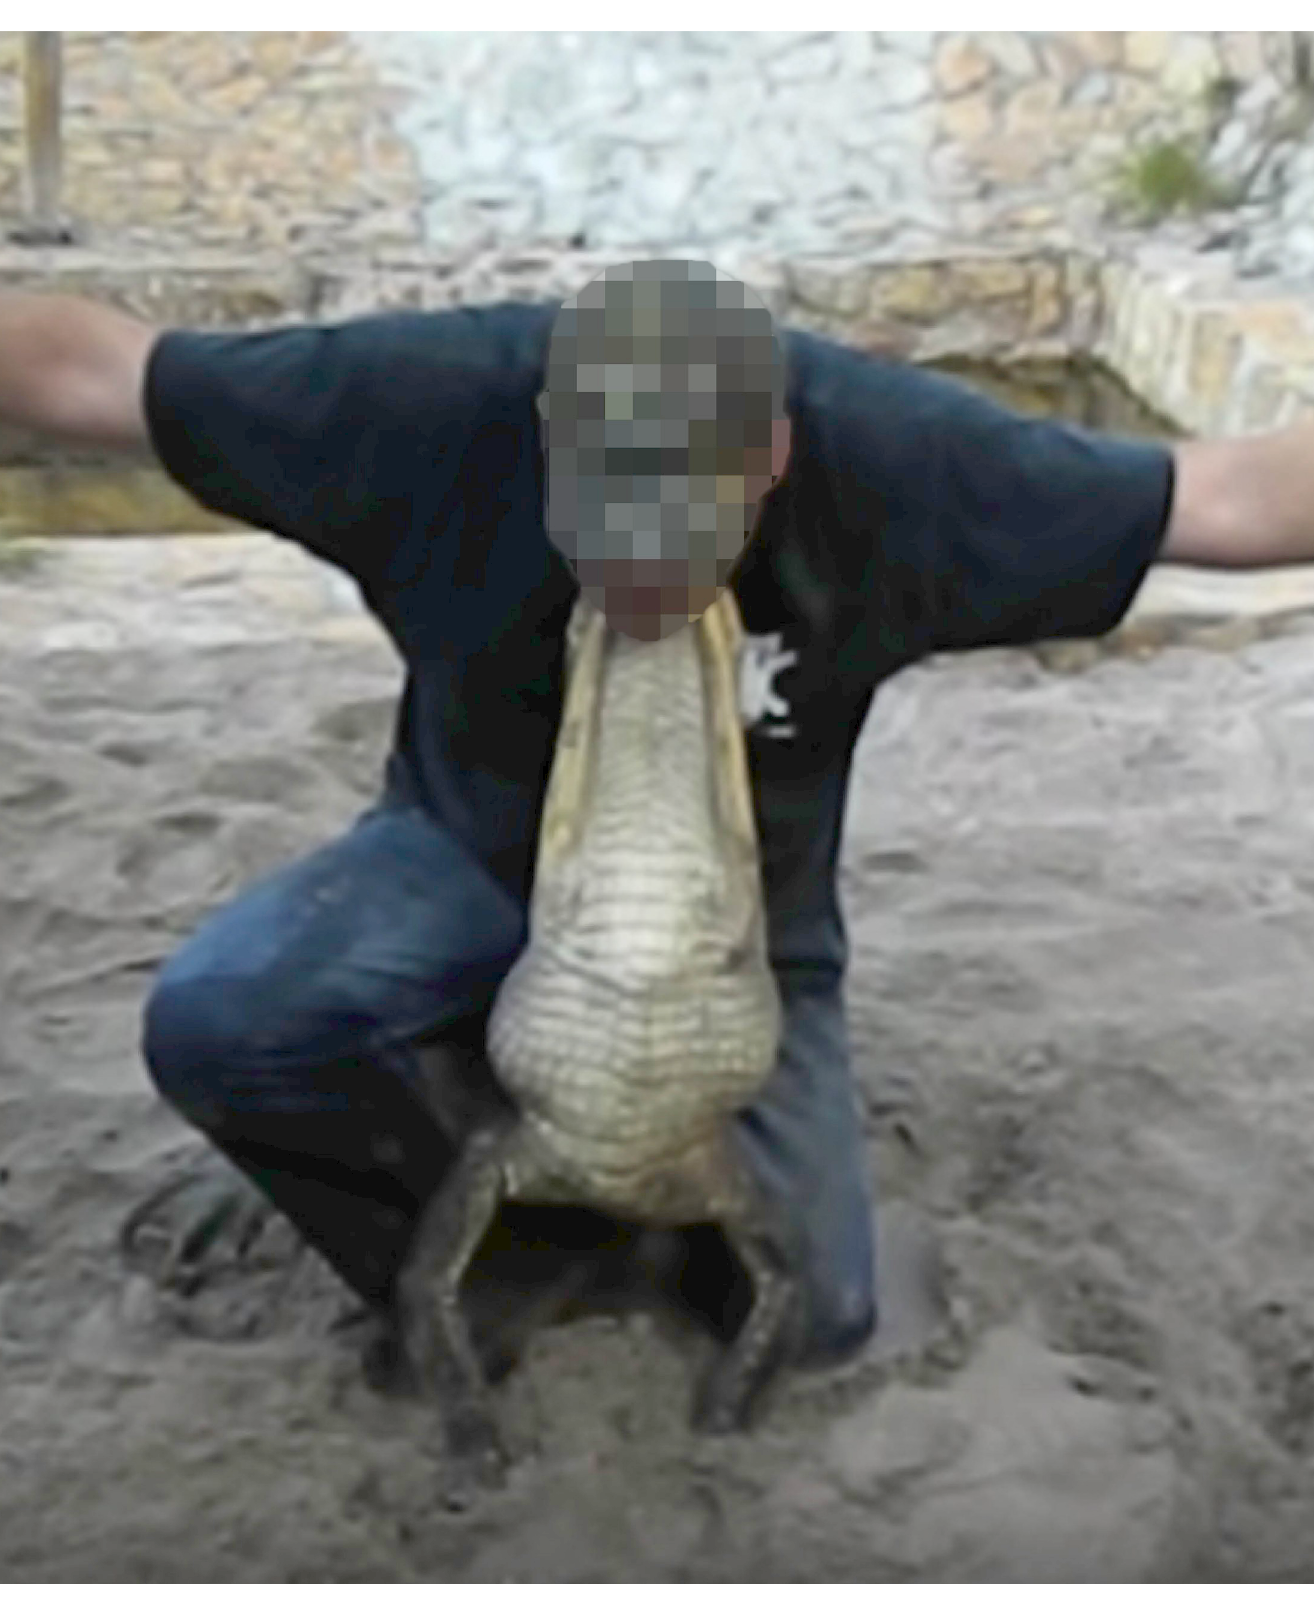
PLOS ONE | https://doi.org/10.1371/journal.pone.0242106 November13,